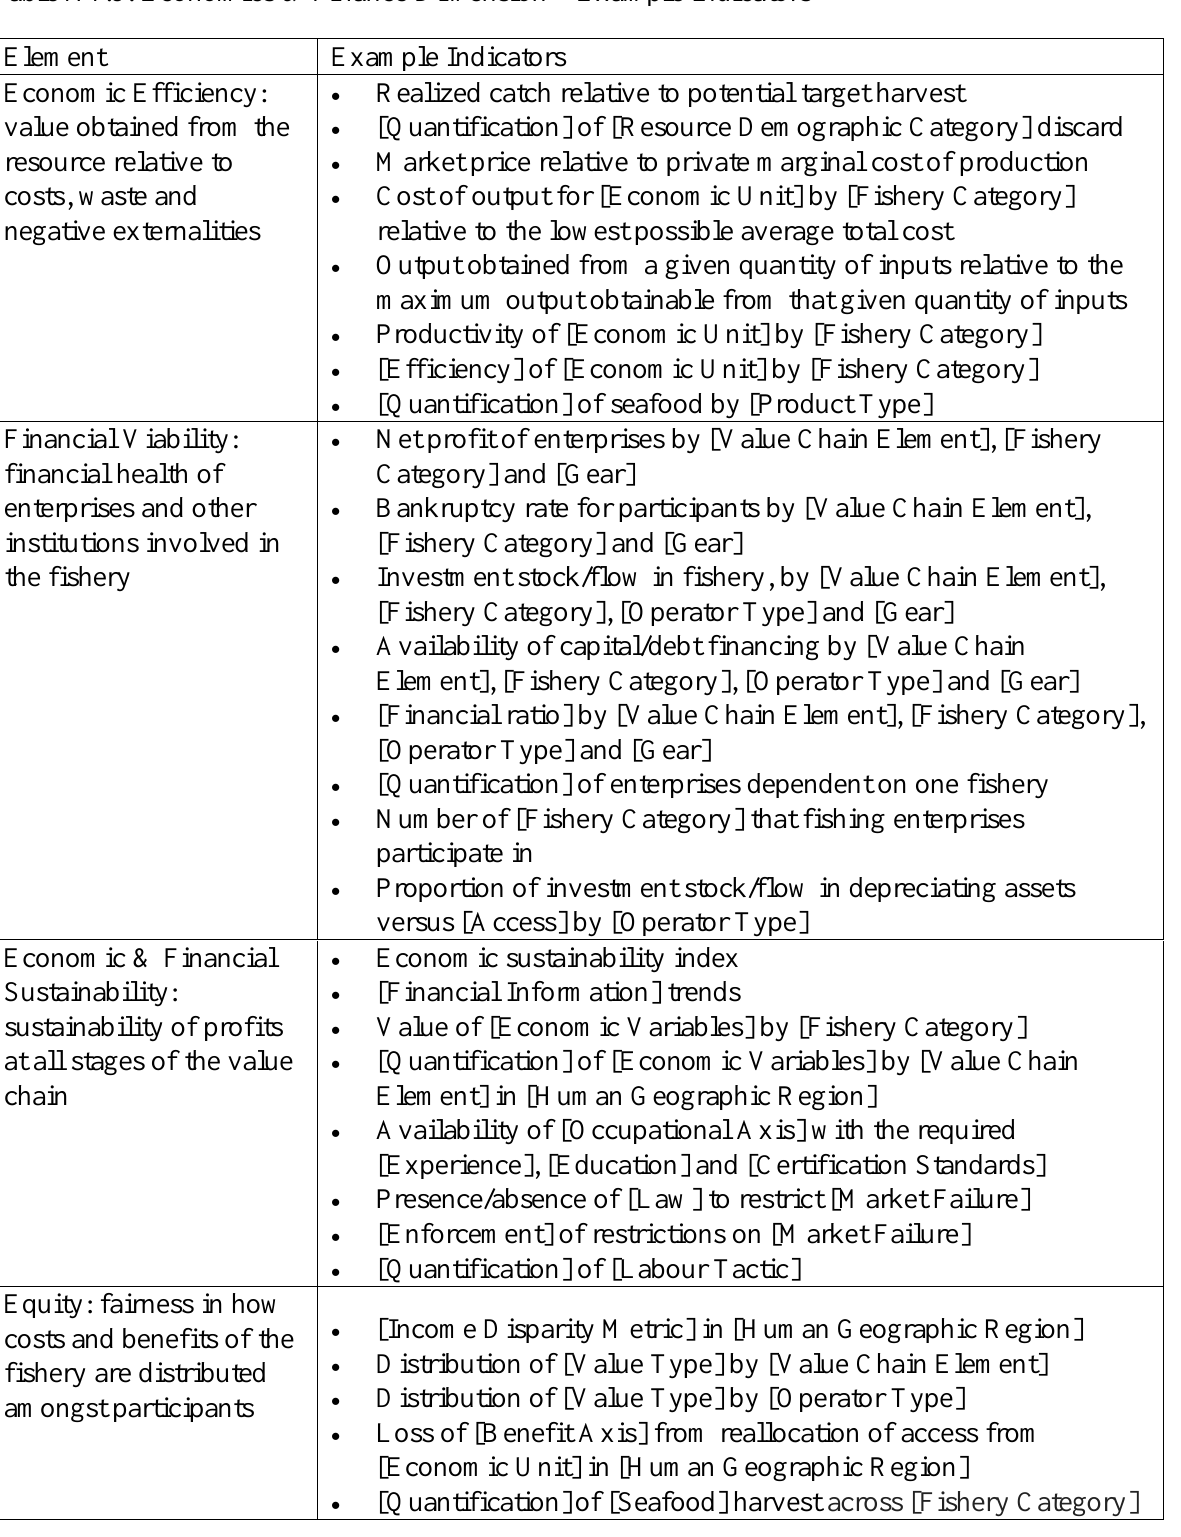
Table A1.8: Economics & Finance Dimension – Example Indicators Element Example